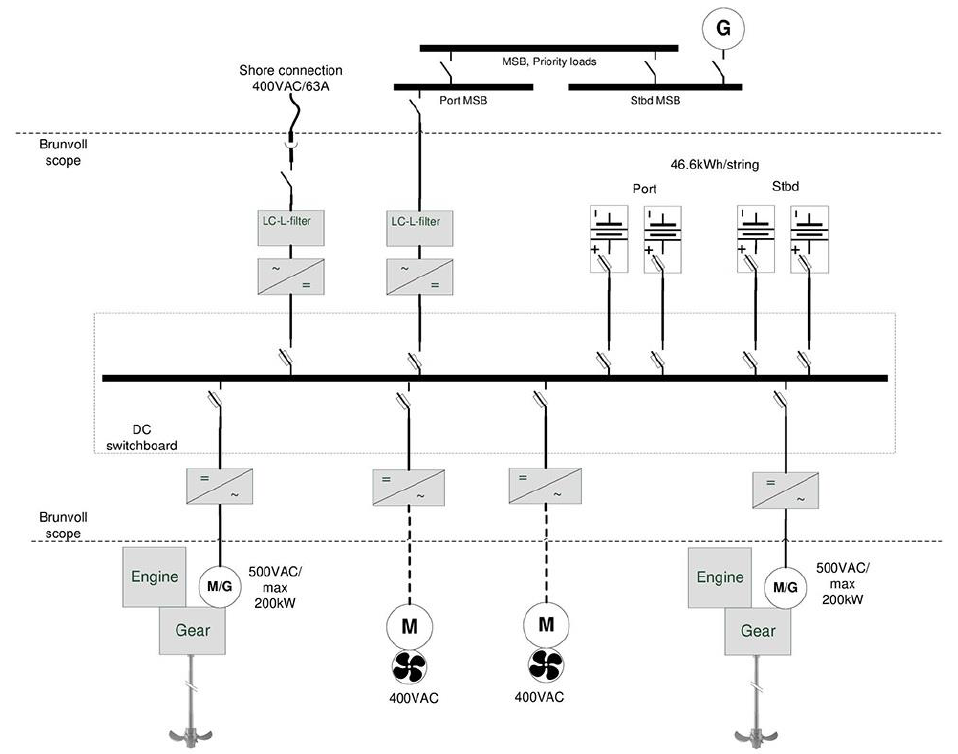
Figure 8. Single-line diagram of the high-speed vessel’s propulsion system [60].